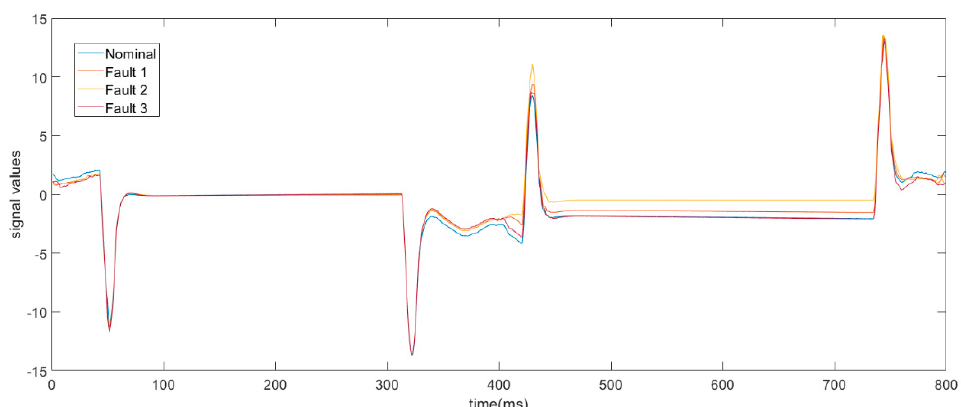
Figure 5. Raw signals produced by the sealing group during the nominal condition and the three fault conditions.